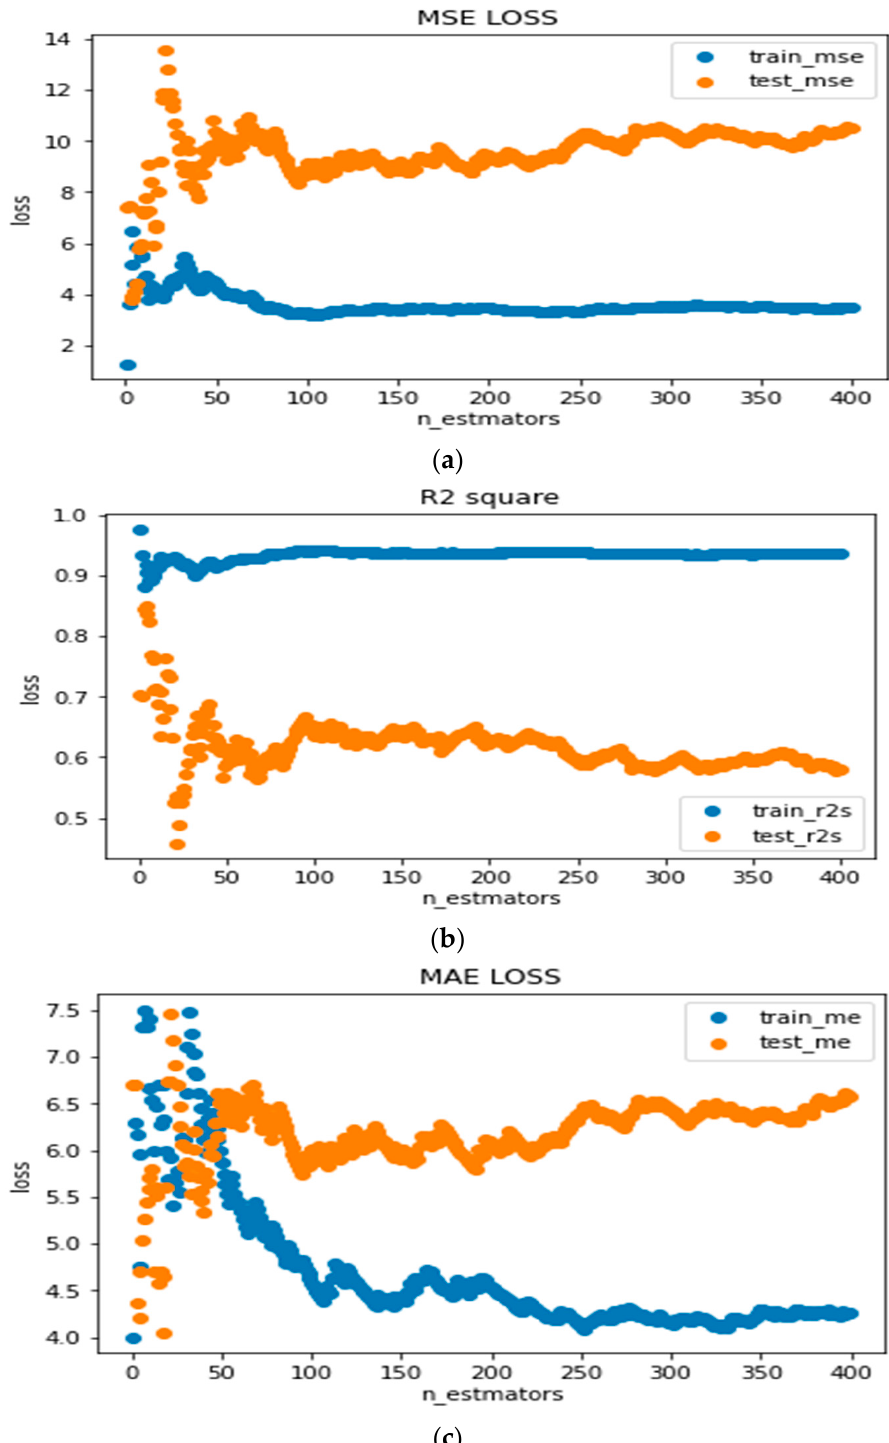
Figure 3. Losses in RFR. ( a ) MSE Losses in RFR ( b ) R2 Losses in RFR ( c ) MAE losses in RFR.